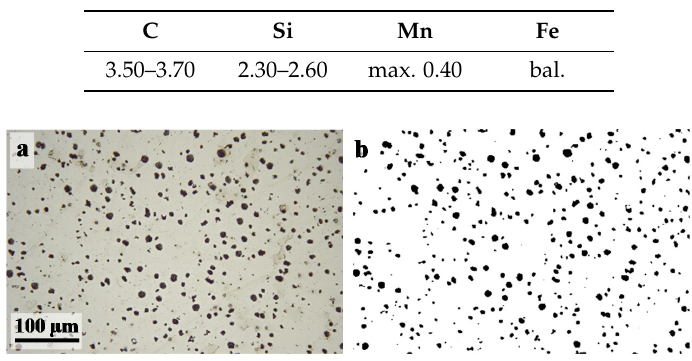
Figure 1. Top ‐ view observation of the spheroidal graphite (SG) cast iron ( a ) before, and ( b ) after image